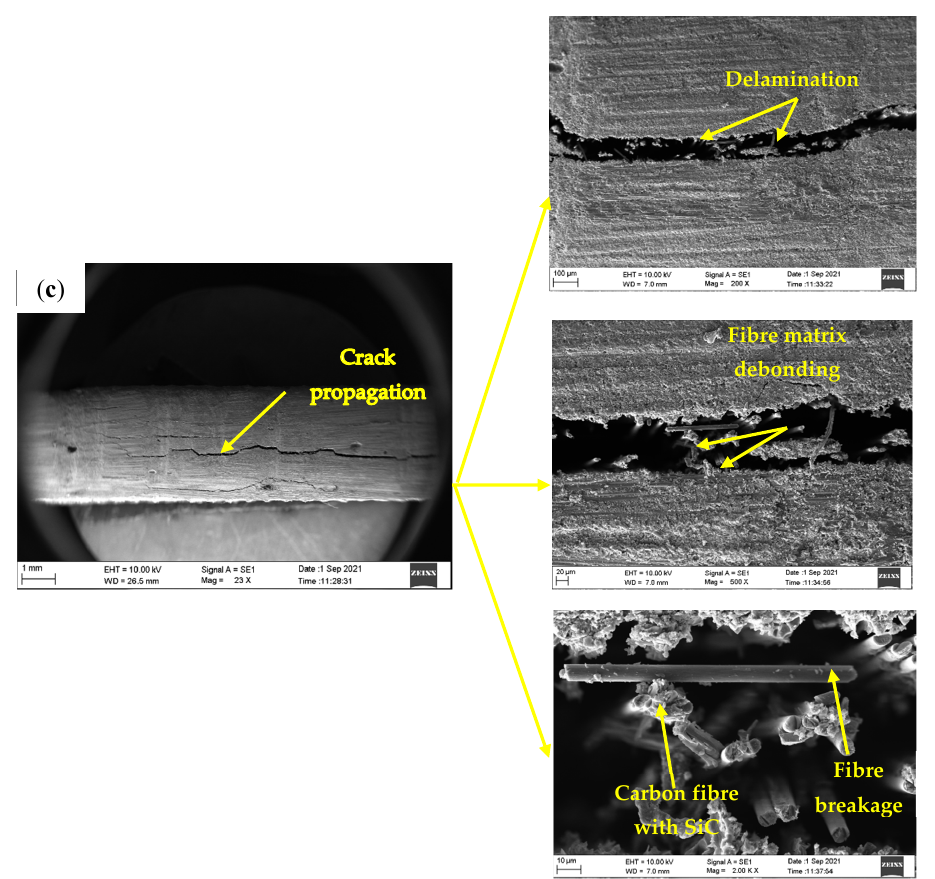
Figure 12. SEM images of shear test fracture specimens: ( a ) neat, ( b ) 1.75 wt.% Al 2 O 3 , and ( c ) 1.25 wt.% SiC nanocomposites at different magnification factors.